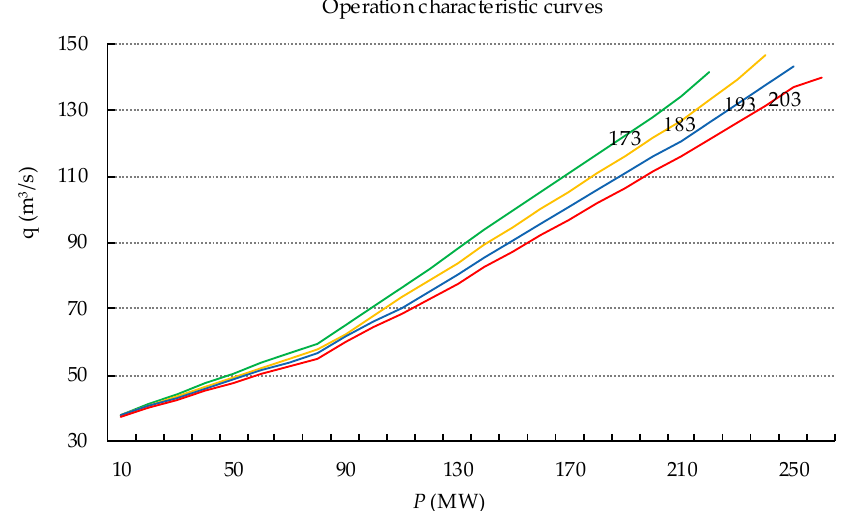
Figure 4. Operation characteristic curves of units for different work water head.